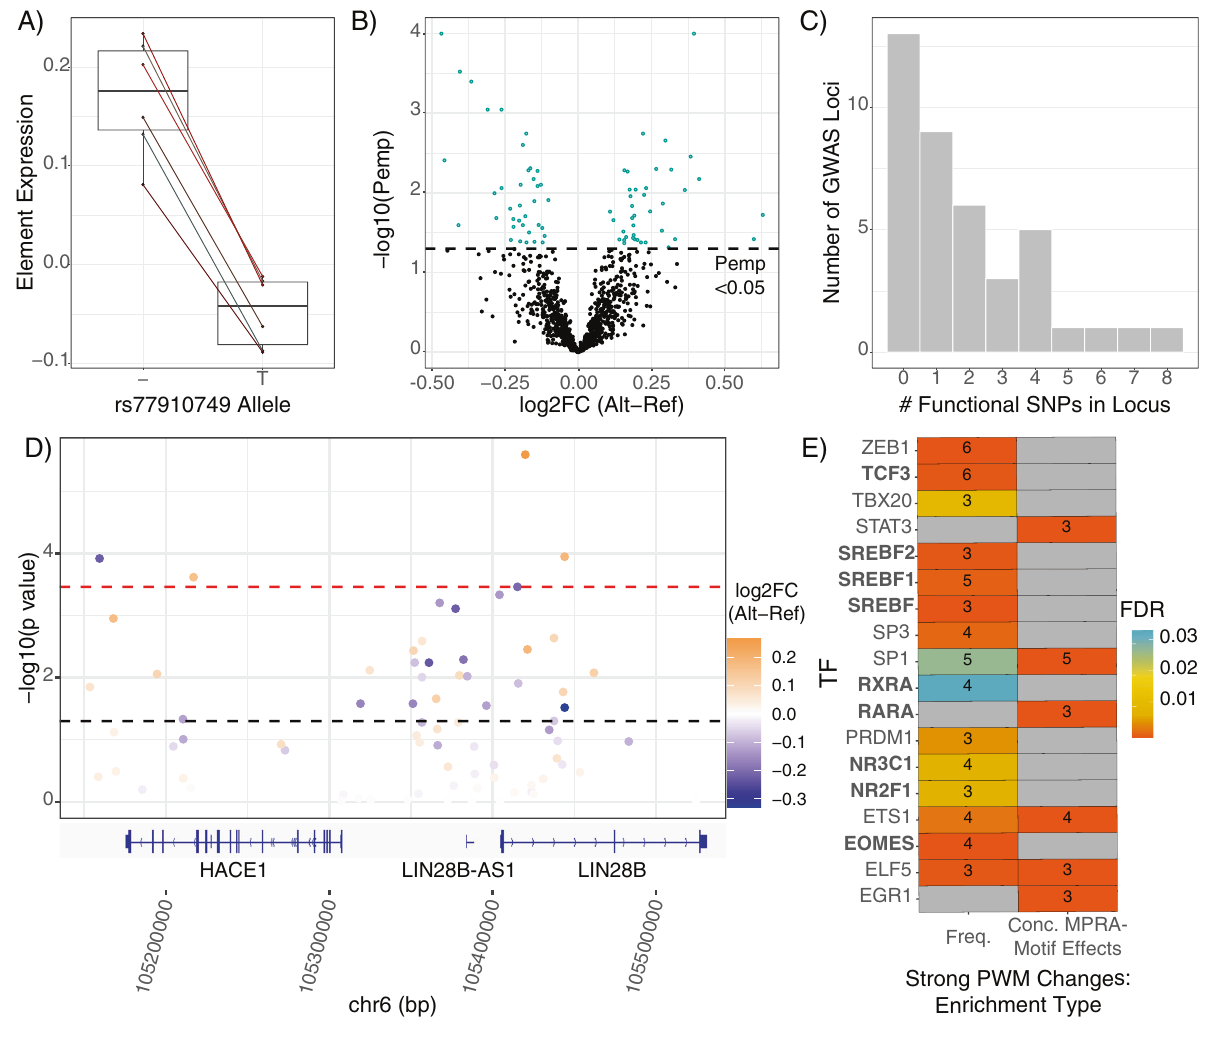
Fig. 2 MPRA de fi nes SNPs with a functional effect on gene expression. A MPRA results of positive control SNP. Shen et al. found that the T allele drove decreased expression relative to the deletion ( “–” ) allele, which was robustly reproduced in the present assay. B Volcano plot of allelic differences in reporter expression. Points represent one SNP ’ s composite log2 allelic fold change (alt vs. ref), determined as the mean of samplewise alternative allele barcode expression minus the matched mean of reference allele barcodes. The dotted line indicates the statistically corrected signi fi cance threshold. C Number of functional SNPs (MPRA-signi fi cant SNPs) per GWAS locus in the assay. Number of loci ( y -axis) containing a given number of MPRA-signi fi cant (Pemp < 0.05) SNPs ( x -axis). D The LIN28B locus harbors several functional SNPs. SNPs are plotted according to their chromosomal position (hg19) and colored based on their composite log2 allelic fold change. Refseq genes are visualized by the Integrative Genomics Viewer [116]. E TF binding motifs involved in retinoid signaling, steroid synthesis and response, and neural activity are enriched among functional SNPs. Boxes are colored by FDR-corrected signi fi cance of enrichment for motifbreakR-de fi ned “ strong ” allelic perturbations to binding motifs among functional SNPs; the number of functional SNPs perturbing (left column) and/or with concordant motif and MPRA effects (right column) are shown. Concordant effects were de fi ned by greater MPRA expression driven by the allele better-matched to the corresponding TF motif and vice versa — the expected behavior of strictly activating